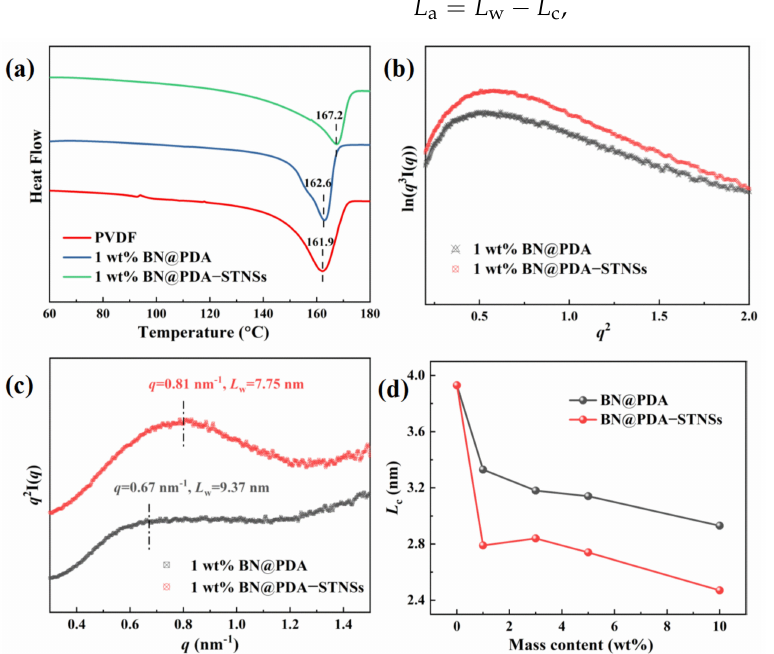
Figure 4. ( a ) The DSC endothermic curves; ( b ) Porod curves; ( c ) Lorentz corrected SAXS profiles; and ( d ) L c of pure PVDF, PVDF/BN@PDA, and PVDF/BN@PDA − STNSs composites. The L c and L a of pure PVDF, PVDF/BN@PDA, and PVDF/BN@PDA − STNSs